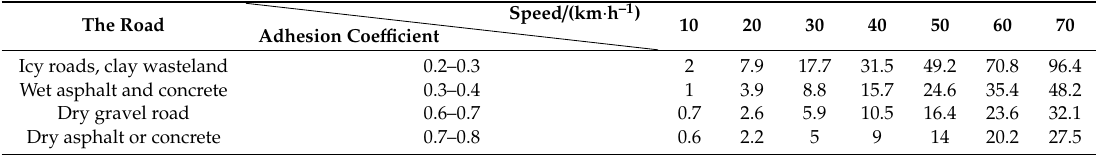
Table 2. The relation between braking distance adhesion coe ffi cient and driving